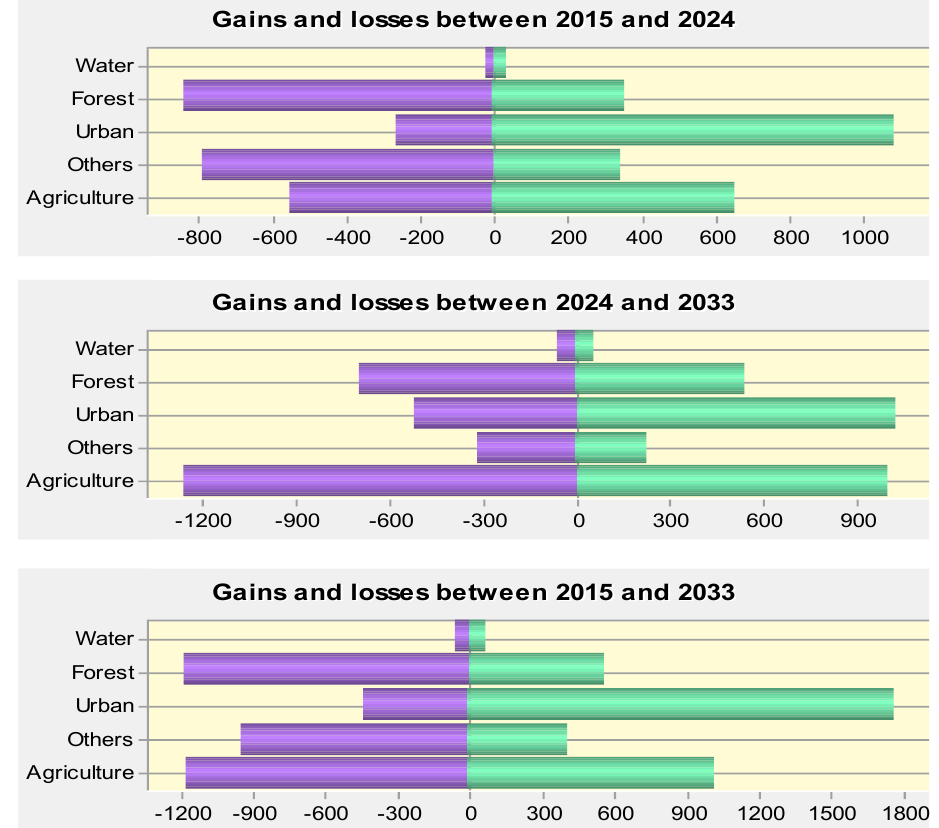
Fig. 7: Gains and losses in each type of land-use in 2015-2024, 2015-2033, and